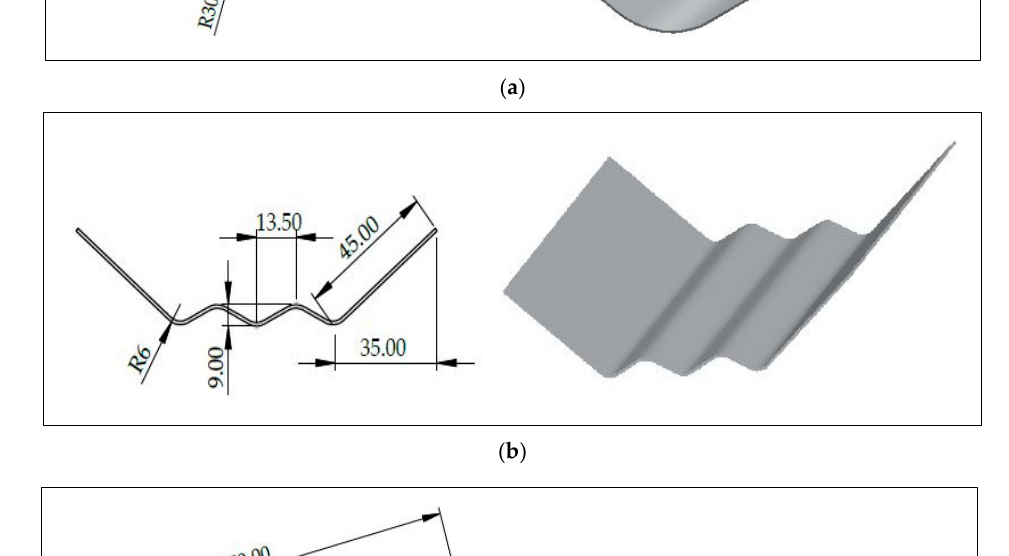
Figure 4. Aspect of tensile test specimen. The final shape of the sheet parts was obtained from a 150 × 150 mm sheet blank. Form1 was a V-type part, form2 was a wavy shape, and form3 was a 3D free-form surface. The technical drawings of the three forms are shown in Figure 5.